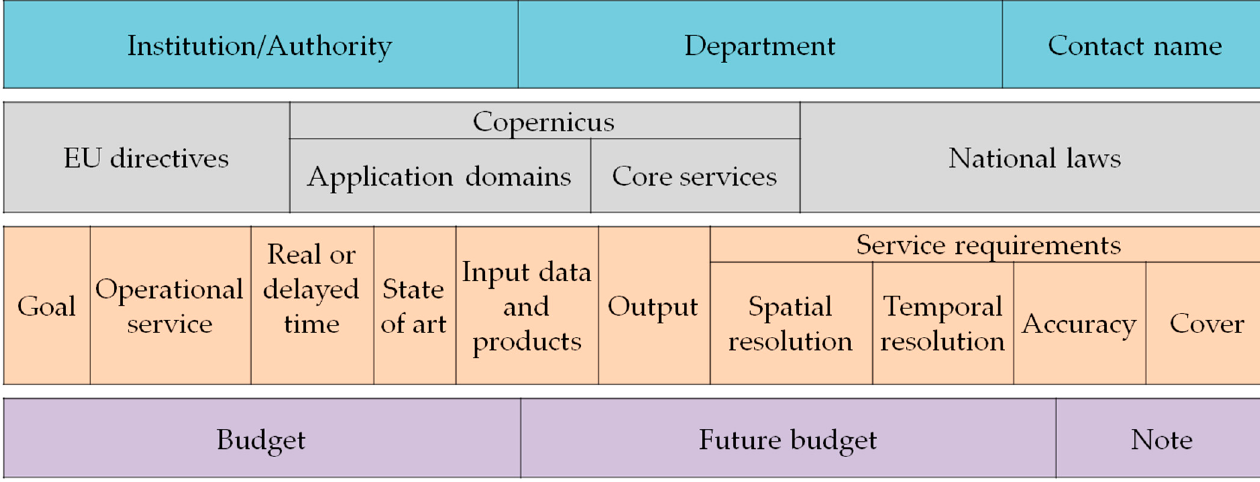
Figure 3. Geographical distribution of the Institutions’ responses.